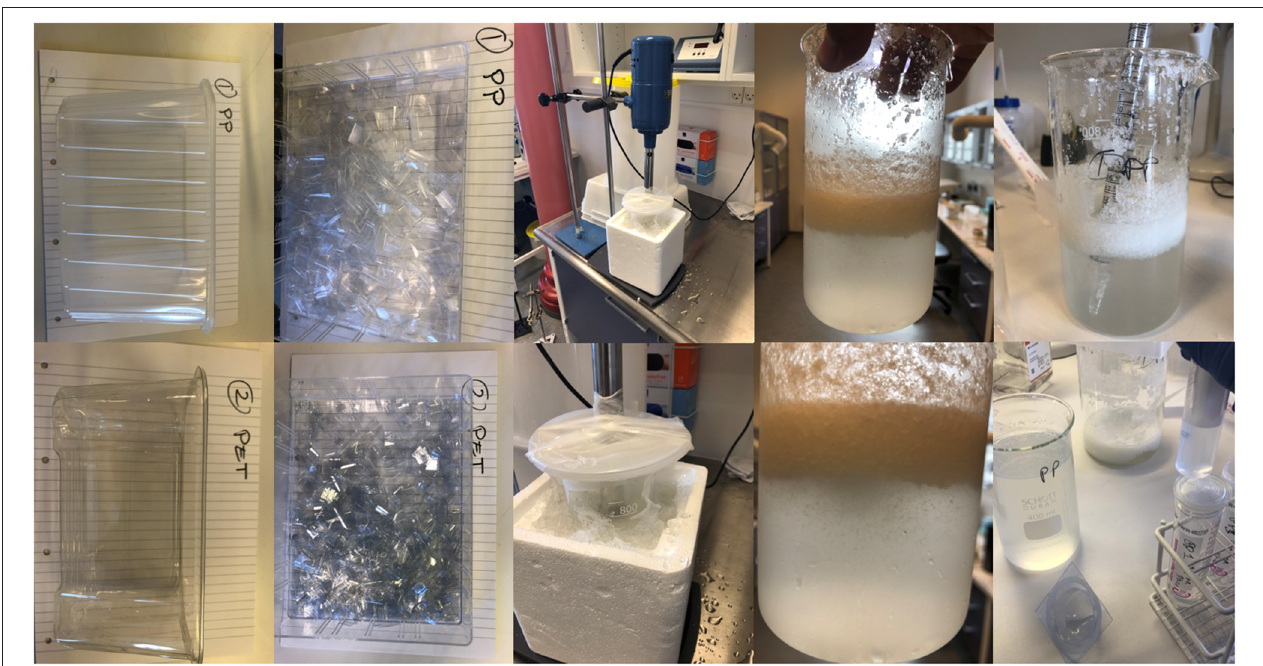
FIGURE 1 | Preparation of polypropylene (PP) and polyethylene terephthalate (PET) suspensions for the pilot study. The images demonstrate from left to right the original food containers, pieces of containers, grinding process, primary slurry of PP and PET plastics